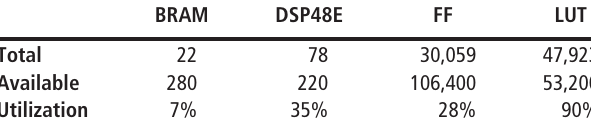
Table 2 Hardware resources utilization information of FPGA